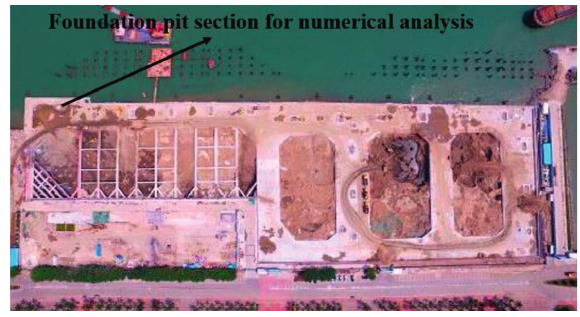
Figure 14: Analytical section plane position